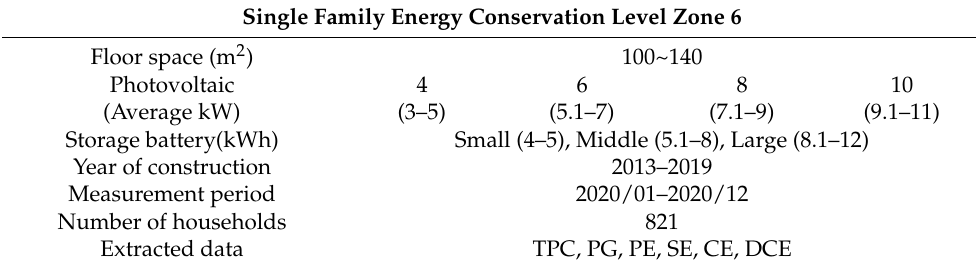
Table 4. Analysis of HEMS data.